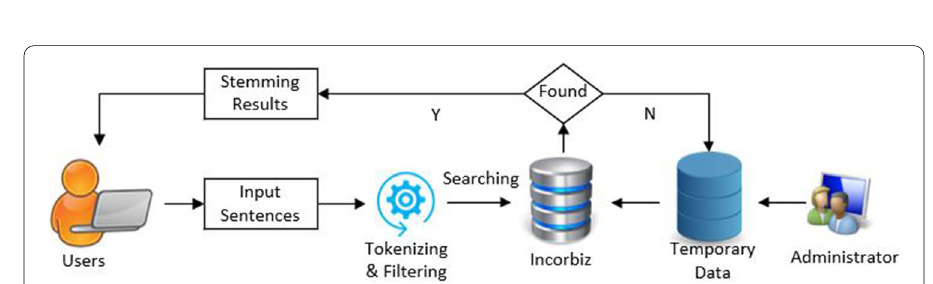
Fig. 2 The Incorbiz’s